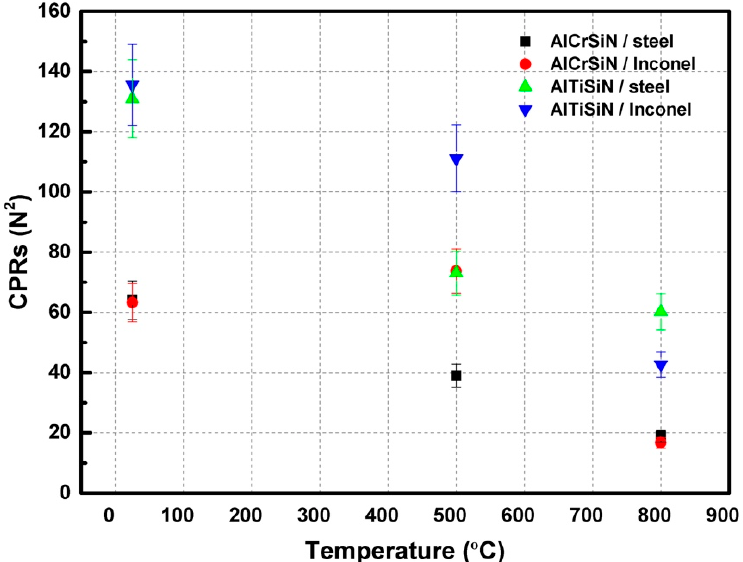
Figure 10. CPR of scratch tests after thermal treatment: AlCrSiN/steel, AlCrSiN/Inconel, AlTiSiN/steel, and AlTiSiN/Inconel.